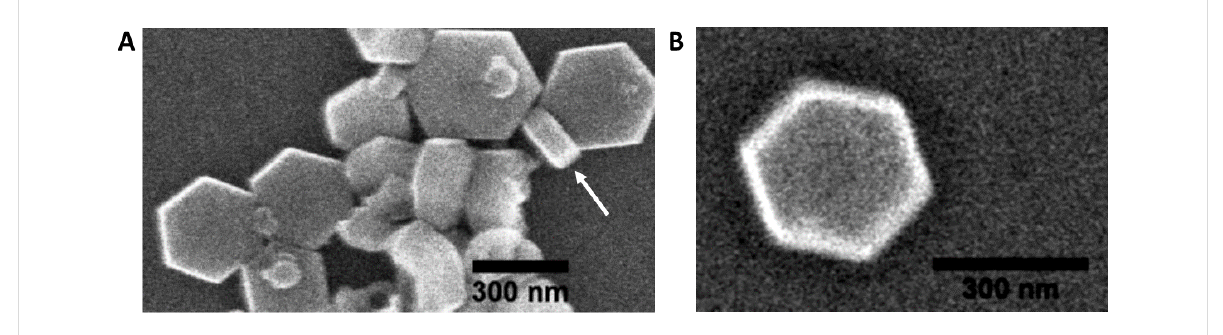
Figure 1: (A) SEM image of synthesized NaYF 4 :Er 3+ ,Yb 3+ UCNPs using thermal decomposition method. (B) An image of a single nanoparticle. The nanoparticle has a hexagonal shape with a diameter of ca. 300 nm and a thickness of ca. 80